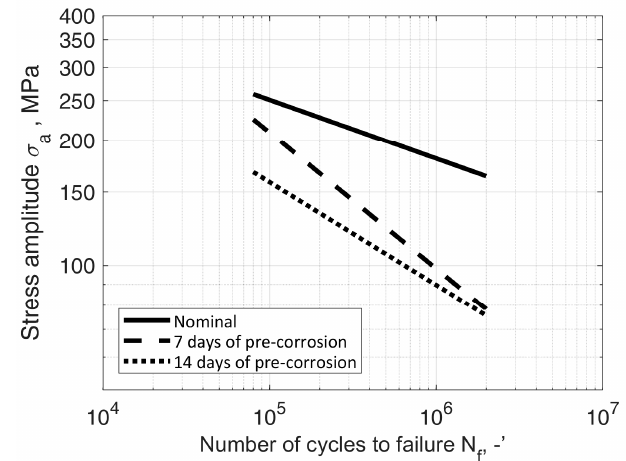
Figure 18. S-N data of AW-2017A-T4 material in nominal condition (room temperature, in air) and samples immersed in tap water solution for 7 and 14 days prior to bending fatigue tests.